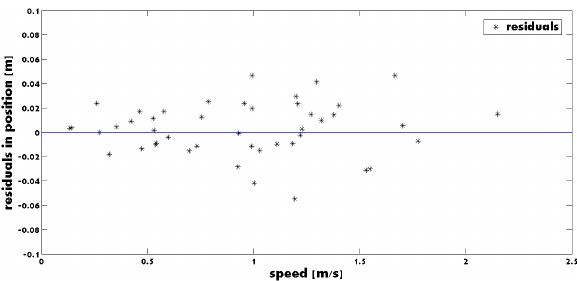
Figure 5. Variations in measured and AT-estimated camera